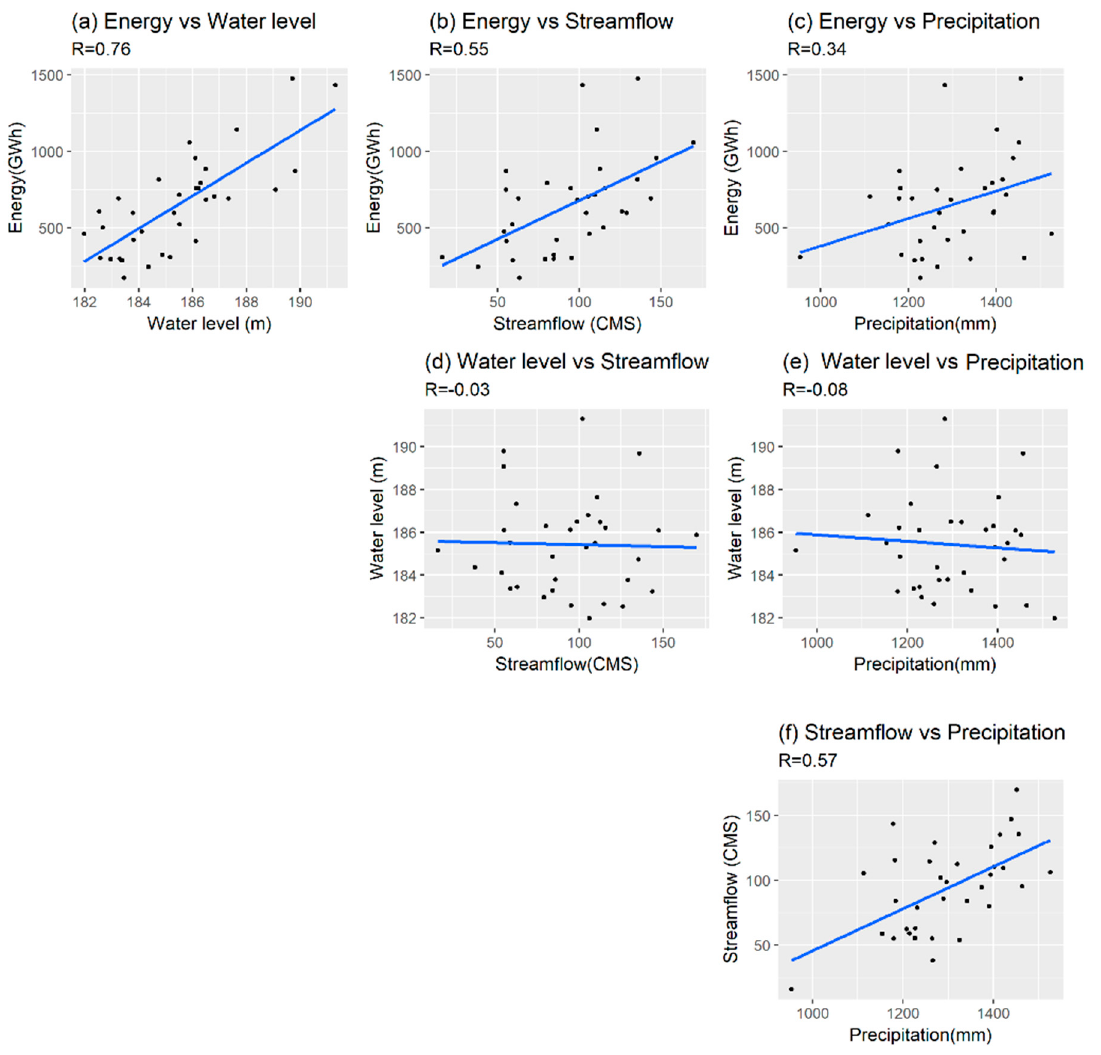
Figure 6. Scatter plot between study variables (1981–2014): top row (E=f(WL, Q,P)); middle raw (WL=f(Q,P)) and bottom raw(Q=f(P)).